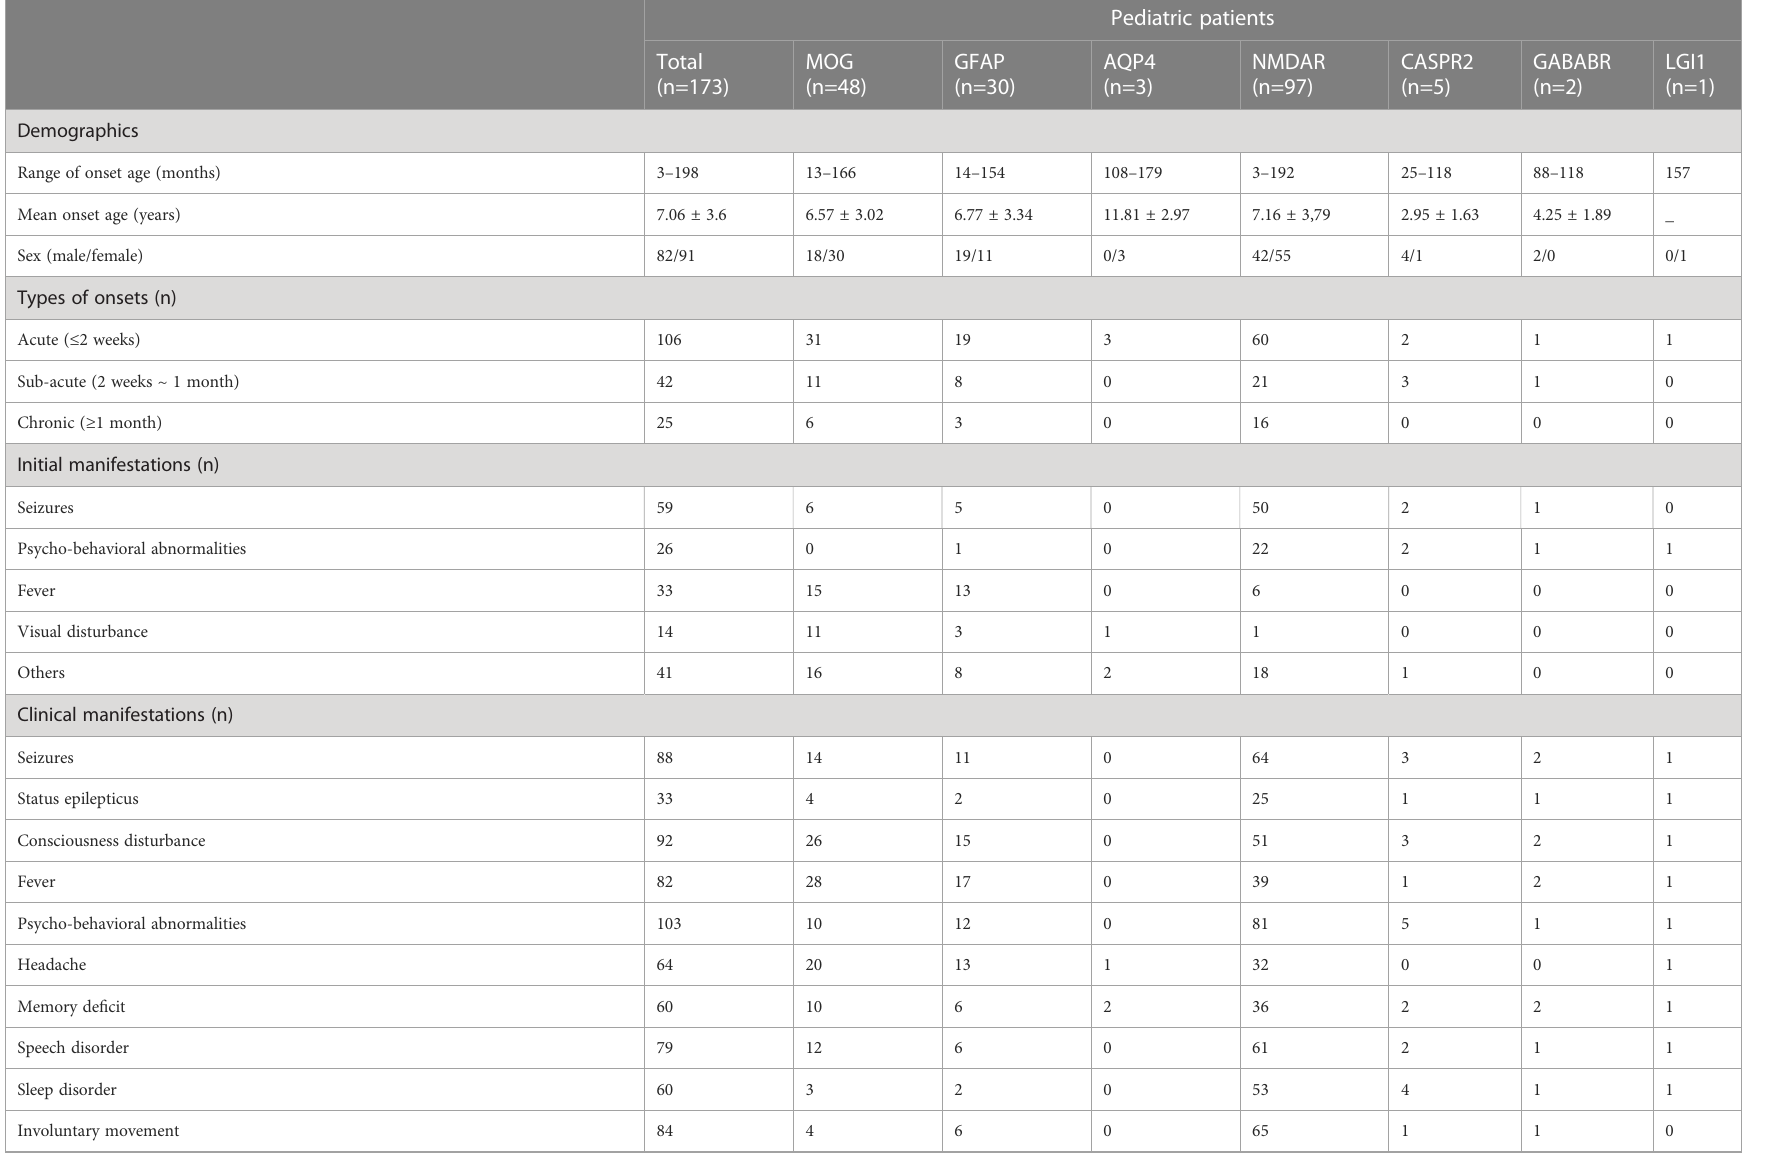
TABLE 2 Demographics, clinical features, auxiliary examinations, treatments, and outcomes of pediatric patients with antibody-mediated autoimmune diseases of the central nervous